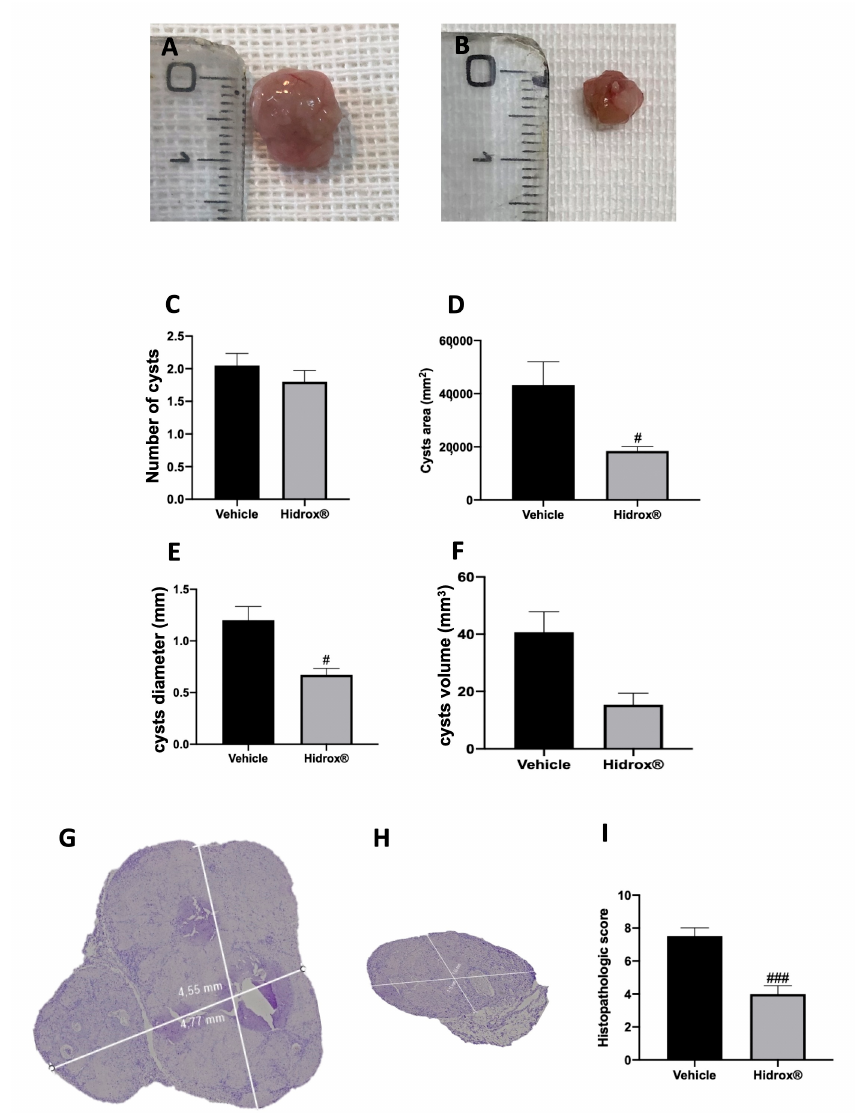
Figure 1. Hidrox ® administration reduced lesion size endometriosis-induced: macroscopic analysis: vehicle ( A ), Hidrox ® ( B ), cyst number ( C ), cyst area ( D ), cyst diameter ( E ), cyst volume ( F ); histological analysis: vehicle ( G ), Hidrox ® ( H ), histopathological score ( I ). For the macroscopic analyses, n = 20 animals from each group were employed. For the histological analyses, n = 5 animals from each group were employed. A p -value of less than 0.05 was considered significant. # p < 0.05 vs. vehicle, ### p < 0.001 vs.